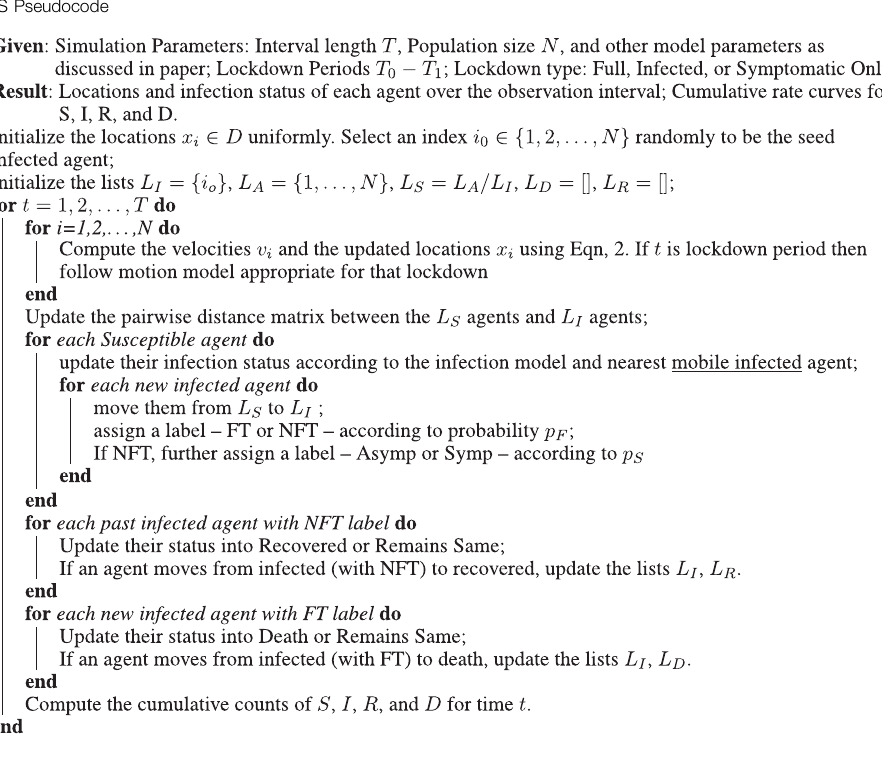
Algorithm 1 | RAW-ALPS